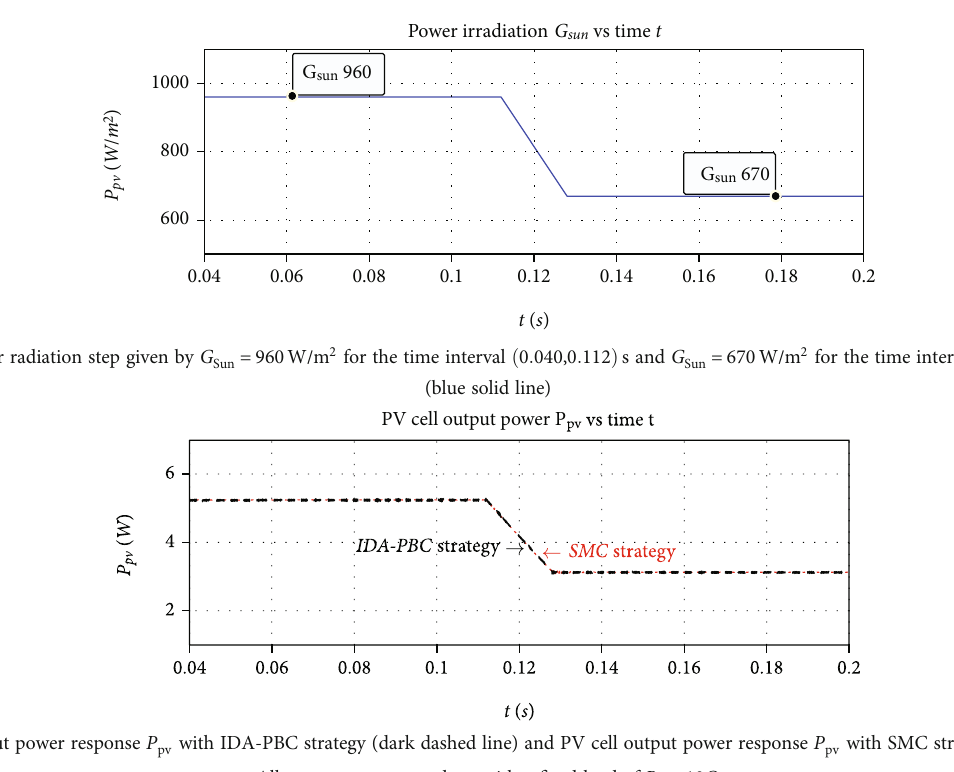
(dashed red line) and C 1 A